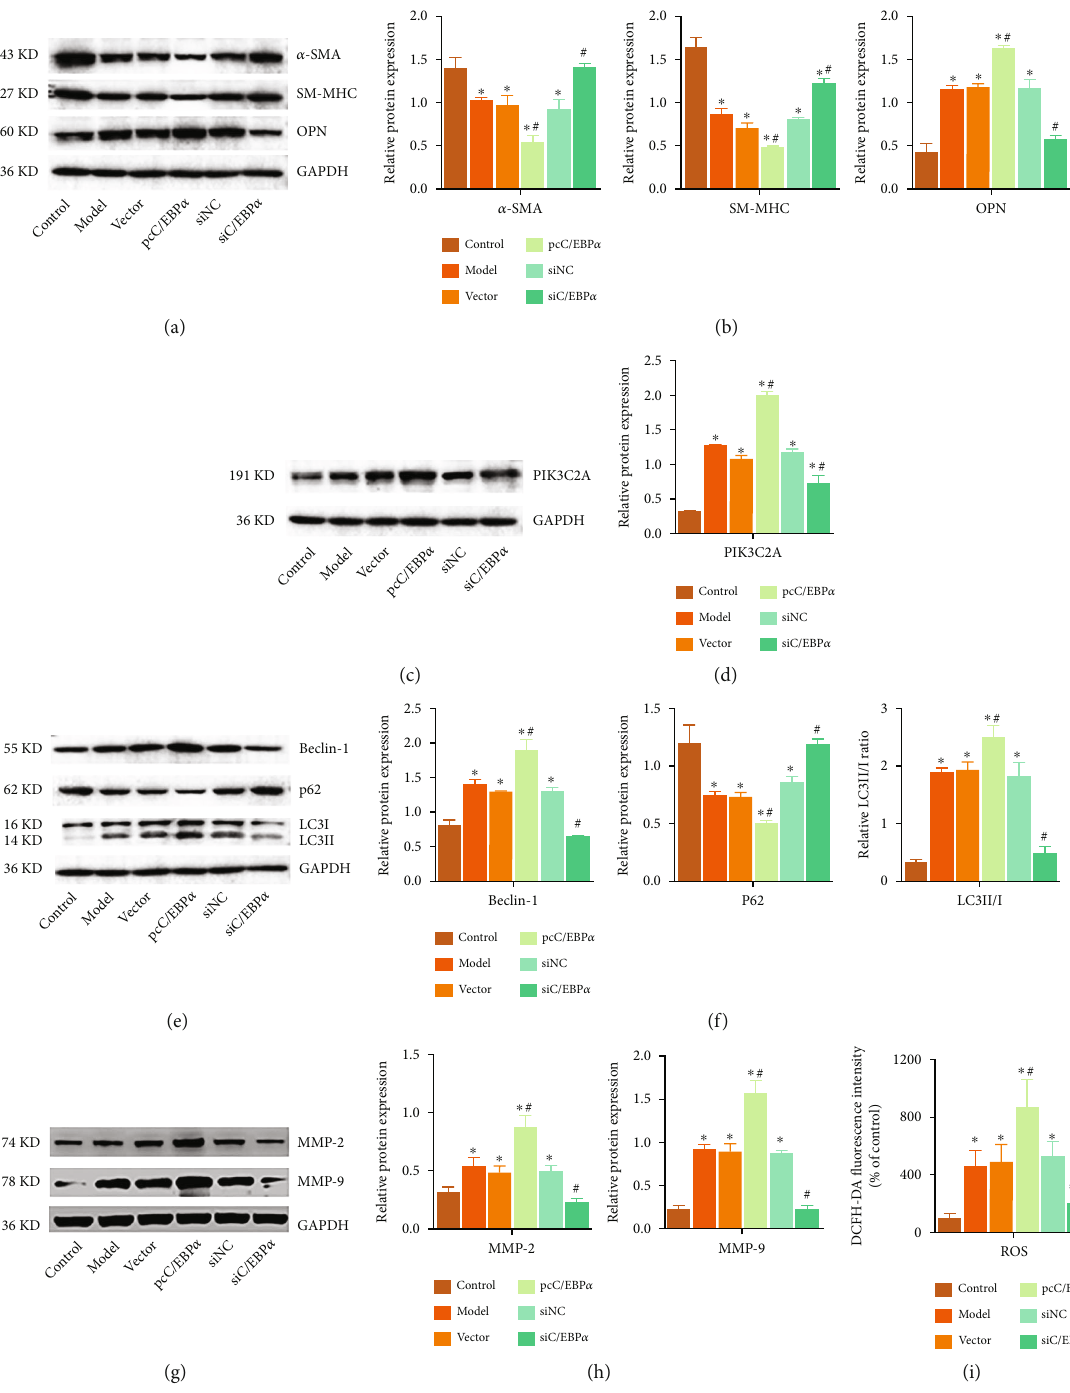
Figure 4: The impact of C/EBP α in angiotensin II- (Ang II-) treated VSMCs. The relative protein expressions in Ang II-treated VSMCs with presence of C/EBP α overexpression or knockdown were analyzed by Western blot. GAPDH was used as an internal control. Data are presented as means ± SEM . (a, b) Evaluation of the in fl uence of C/EBP α on the expression of α -SMA, SM-MHC, and OPN proteins. (c, d) Evaluation of the in fl uence of C/EBP α on the expression of PIK3C2A protein. (e, f) Evaluation of the in fl uence of C/EBP α on the expression of Beclin-1, p62, LC3II, and LC3I proteins. (g, h) Evaluation of the in fl uence of C/EBP α on the expression of MMP-2 and MMP-9 proteins. (i) Intracellular ROS was measured by fl ow cytometry using DCFH-DA probe with presence of C/EBP α overexpression or knockdown. Control: control group; model: treated with 1 μ M Ang II; vector: treated with 1 μ M Ang II in vector transfected VSMCs; pcC/EBP α : treated with 1 μ M Ang II in C/EBP α -overexpressed VSMCs; siNC: treated with 1 μ M Ang II in siRNA NC-transfected VSMCs; siC/EBP α : treated with 1 μ M Ang II in C/EBP α -knockdown VSMCs. ∗ P < 0 : 05 vs. control, # P < 0 : 05 vs.